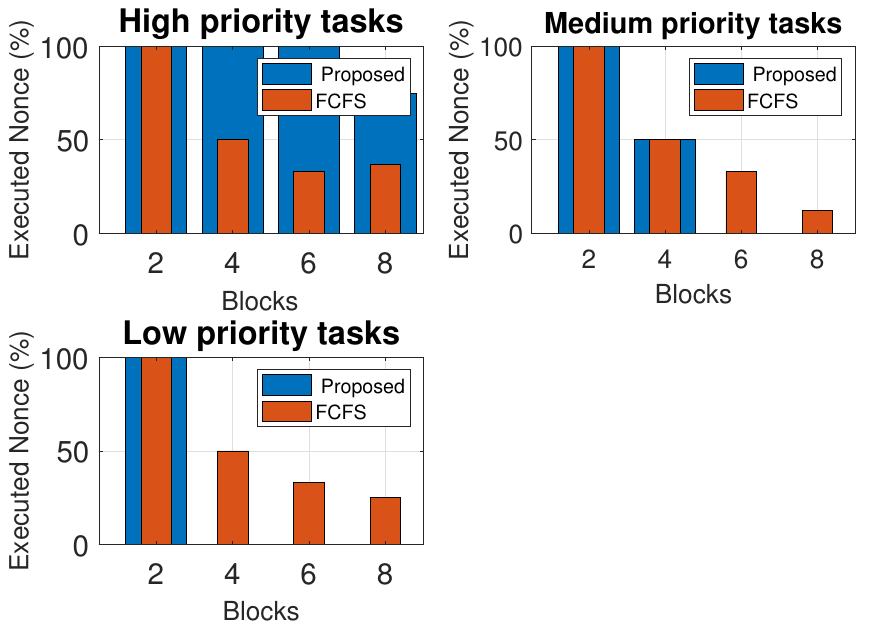
Figure 8. Percentage of the computed nonce for 6 mining nodes with varying number of data blocks.